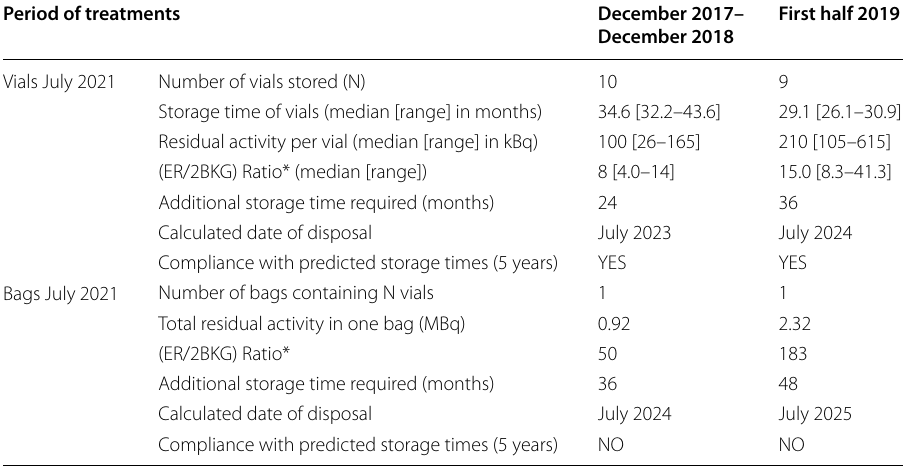
* ER Exposure rate measured in contact with the container; 2BKG background